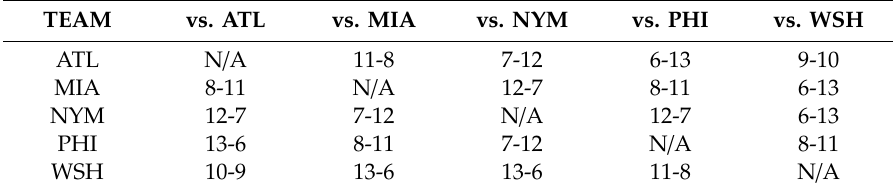
Table 2. National League East head-to-head records for 2017 [8]. TEAM vs. ATL vs. MIA vs. NYM vs. PHI vs. WSH ATL N / A 11-8 7-12 6-13